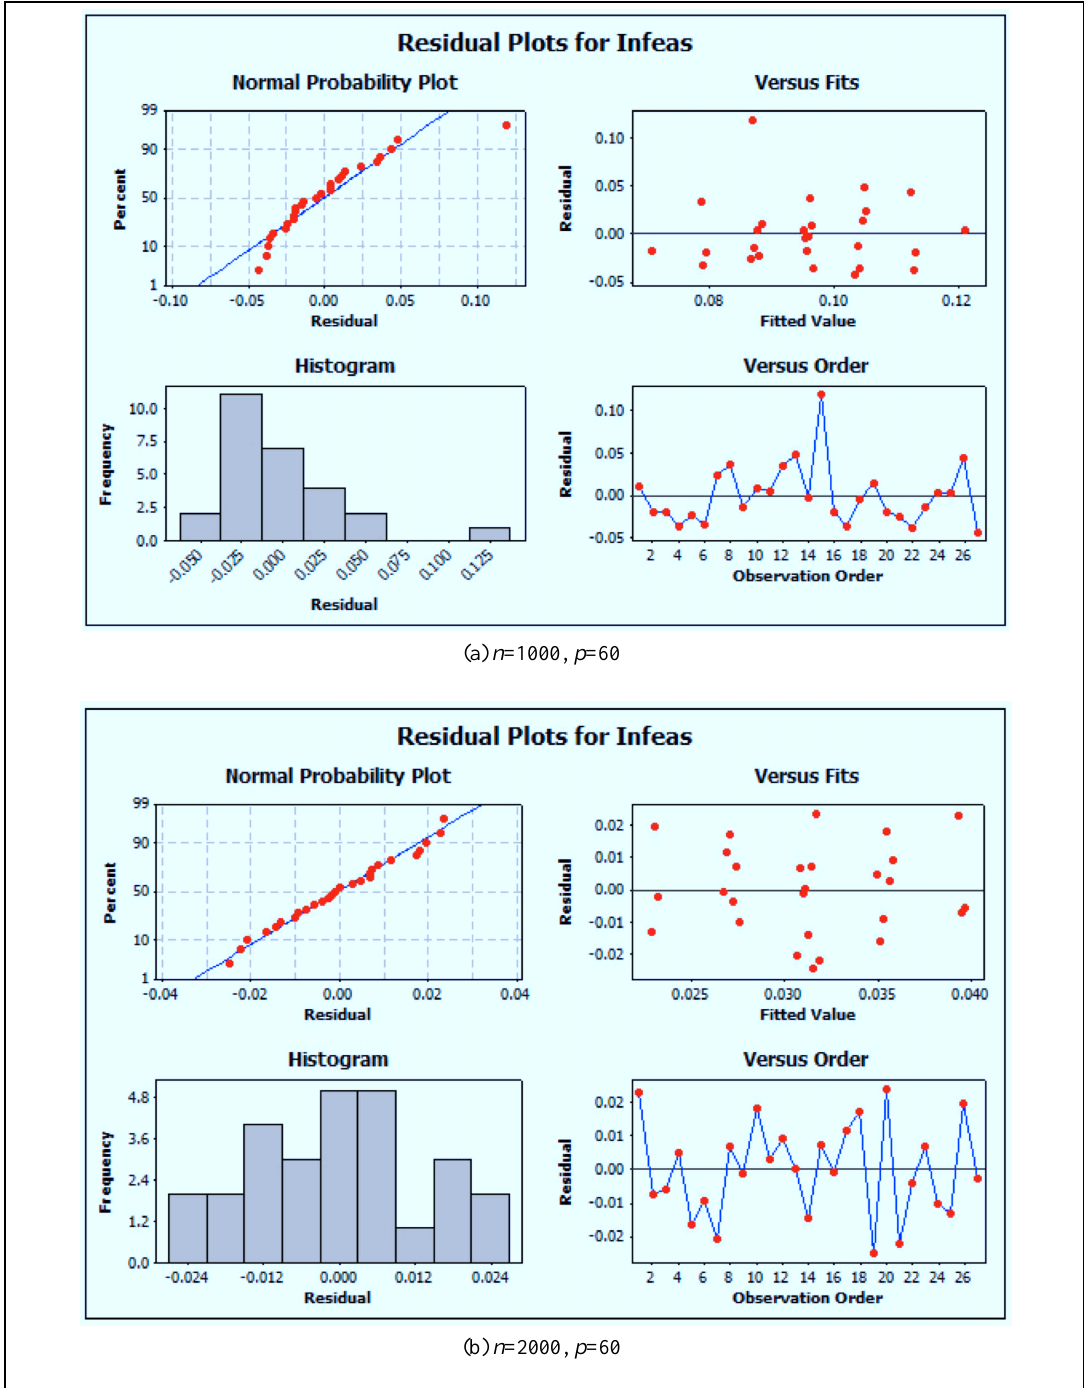
Fig. 8. Residual plots for infeasibility (Infeas) for p =60